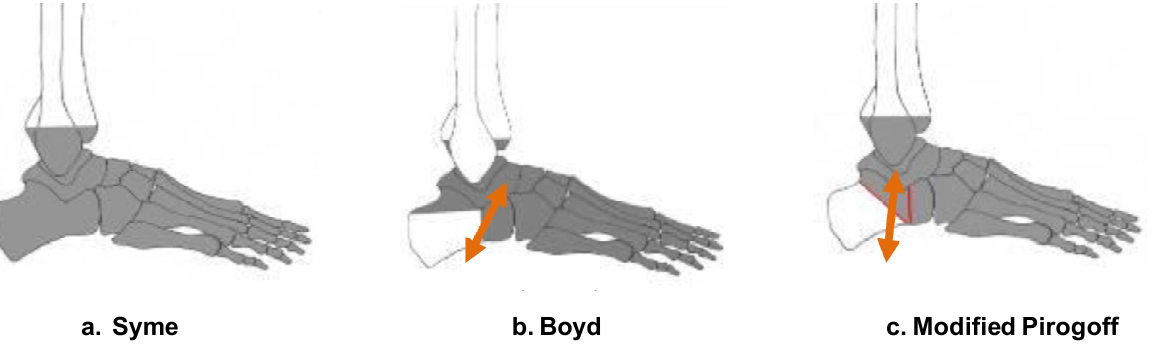
Figure 27. Diagrams of various amputation sites. Bones removed are shaded in